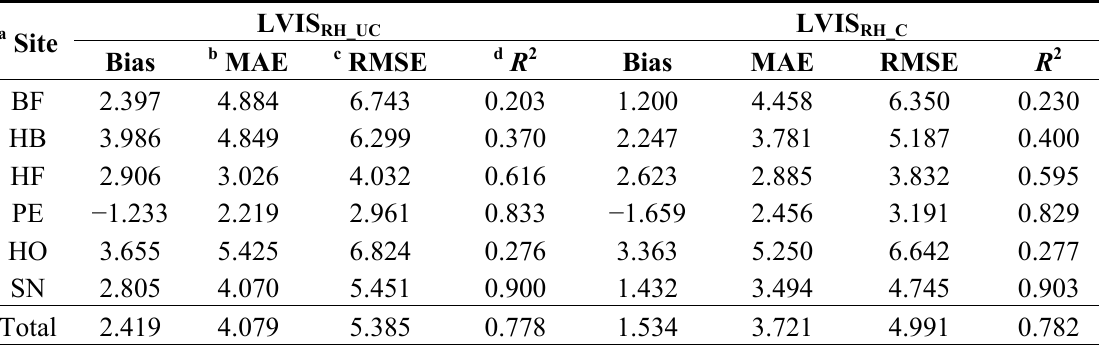
Table 4. Site-specific comparisons between uncorrected (LVIS ) LVIS (LVIS RH_UC